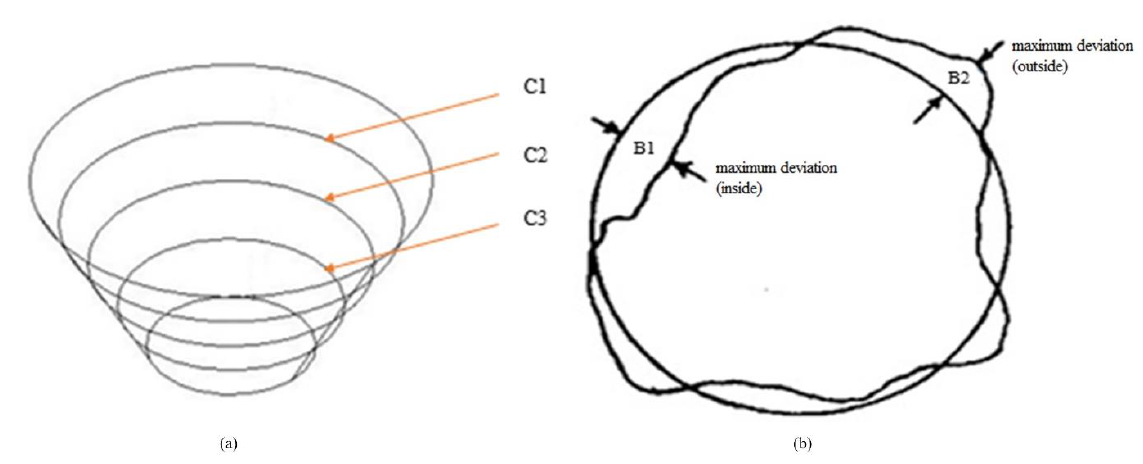
Figure 2. Circularity error: ( a ) level of circular path in XY-plane; ( b ) circularity deviation . The waviness error was determined by selecting approximately 200 points along 4 paths (W1, W2, W3, and W4), as shown in Figure 3a. The recorded points were used to fit a line using the least squares method. This process was repeated along each of the four paths that were 90° apart. Figure 3b shows the maximum deviations from the line (A1 and A2). According to ASME B46.1-1985 [24], the waviness deviation is calculated as the sum of A1 and A2. Using two values, the waviness error is expressed as the average and max- imum of each part’s four deviations. Figure 3. ( a ) Surface waviness paths and ( b ) maximum and minimum deviation along path.